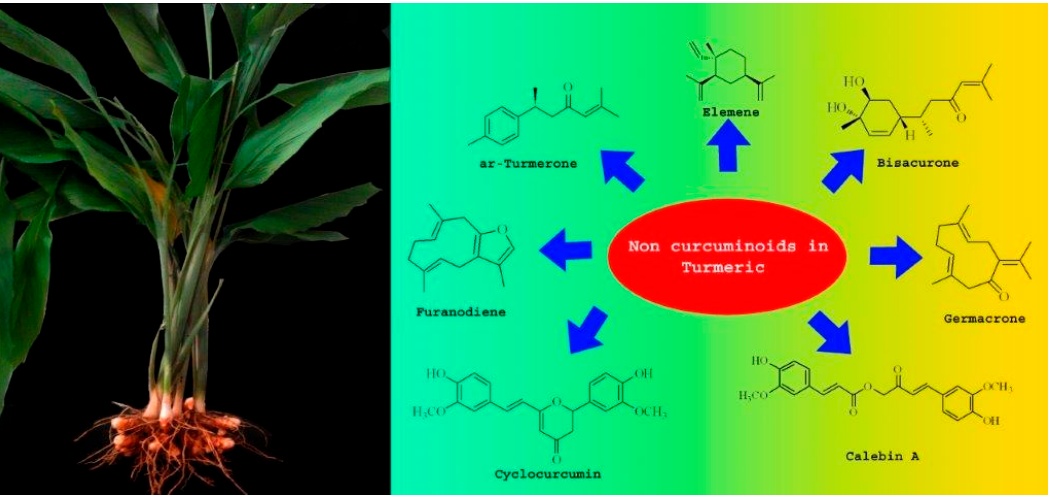
Figure 2. Chemical structures of selected non-curcuminoids from turmeric. Table 2. Various anticancer activities of non-curcuminoids.